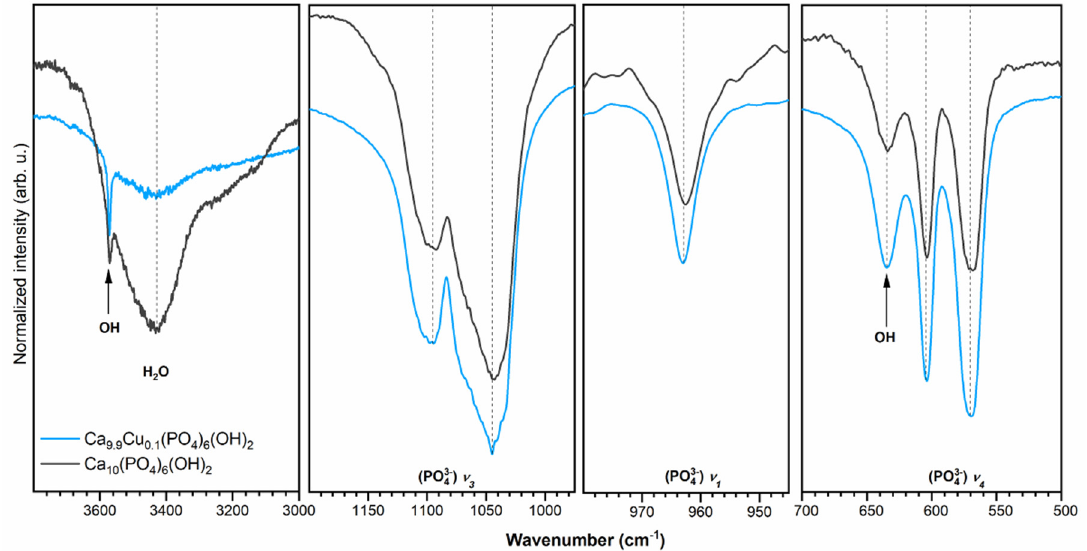
Figure 2. FT-IR spectra of nHAp and nHAp doped with 1 mol% Cu 2 + with an indication of typical active vibrational bands.